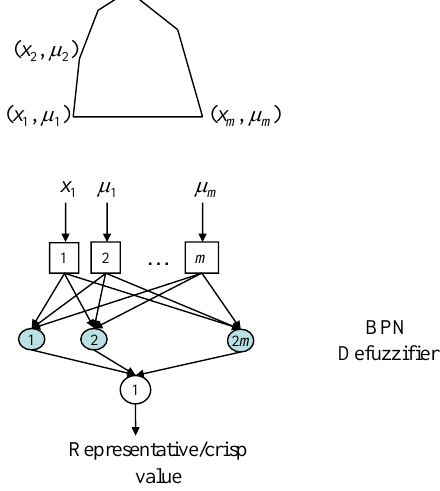
Figure 6. The role of the BPN defuzzifier.